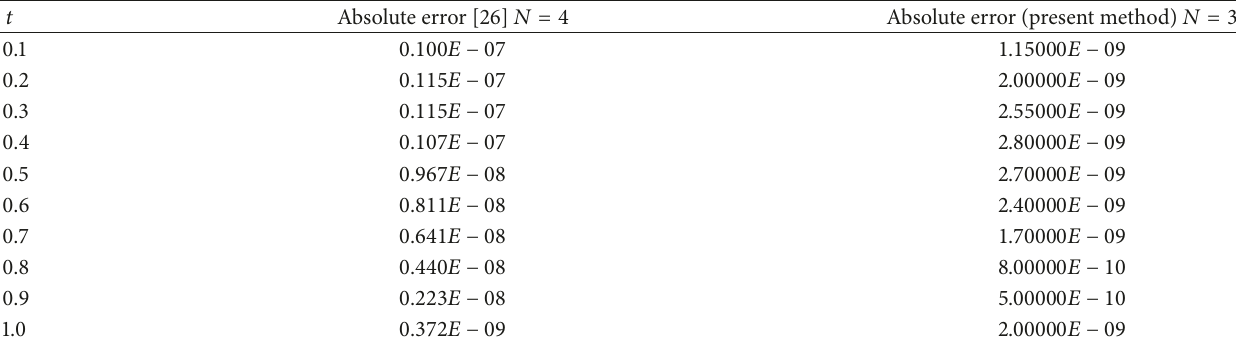
Table 4: Comparison of the absolute errors obtained by the present method and those in [26] for Example